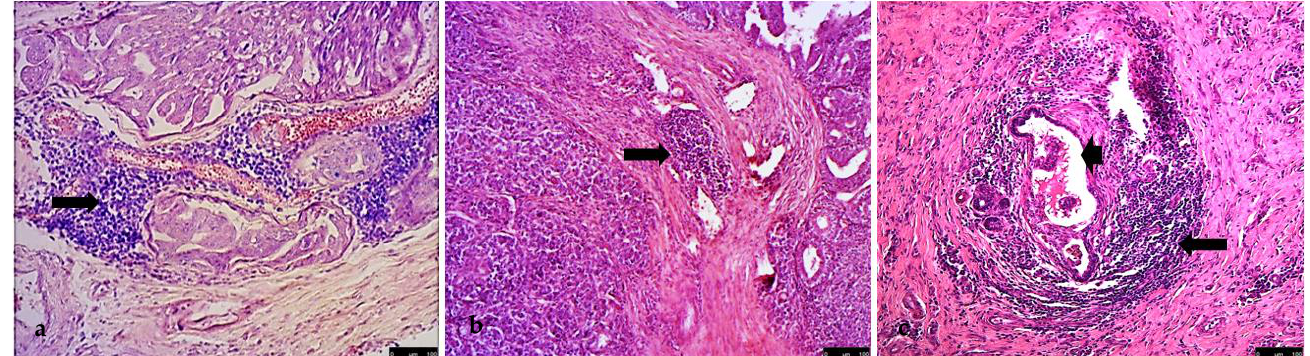
Figure 3. In high-grade carcinomas, ( a ) tubulopapillary carcinoma (10 × ) and ( b ) solid carcinoma (10 × ), inflammatory infiltrates with a follicle-like disposition: numerous lymphoid-like cells as- sumed a concentric pattern around intact vessels (arrow) or ( c ) vessels containing neoplastic emboli (arrowhead, HE, 10 × ).